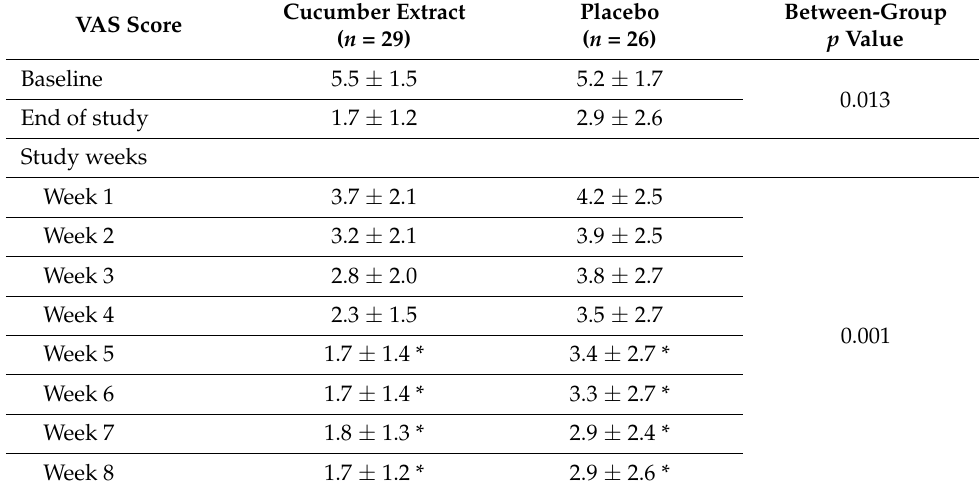
Table 3. Changes in VAS scores for intensity of knee pain in the study groups.